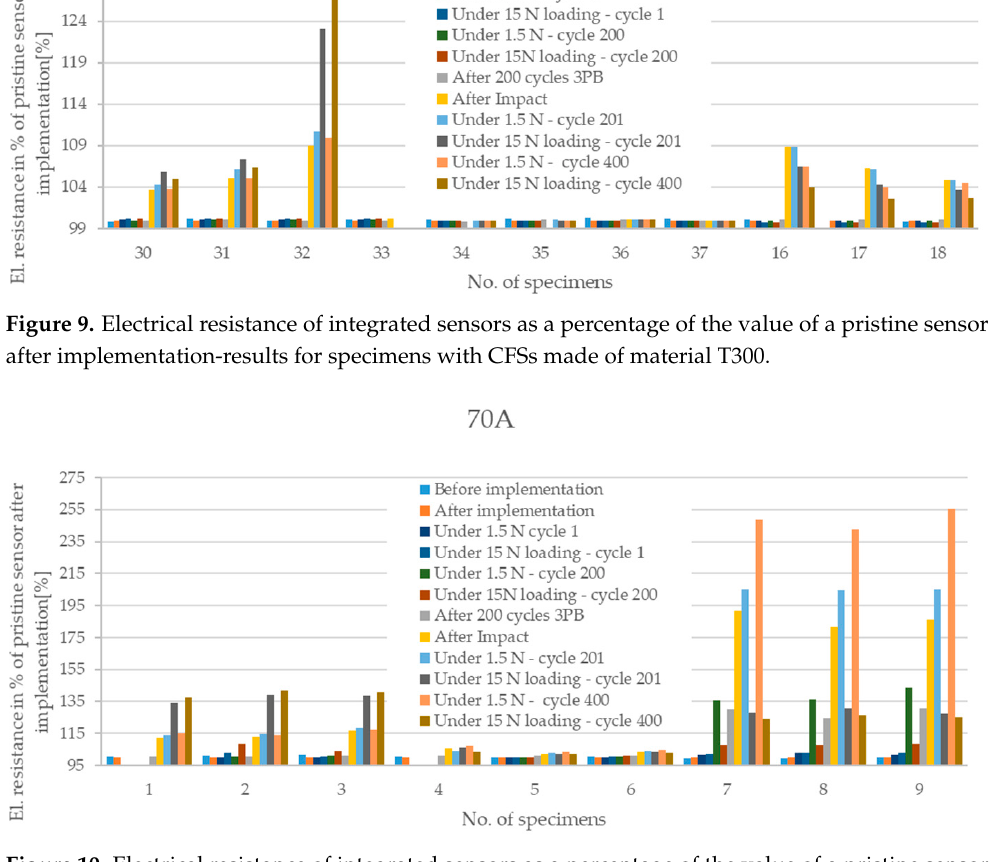
Figure 11. Electrical resistance of integrated sensors as a percentage of the value of a pristine sensor after implementation-results for specimens with CFSs made of material 95 A . Peak-to-peak values after impact for sensors made of the most brittle material 95 A are not given, because the specimens with sensors of this type were not subjected to the second campaign of cyclic loading. 3.3. Active Thermographic Inspection and Computer Tomography An active thermographic inspection of the specimens before loading revealed damage to the electrical contacts of the sensors made of pitch carbon fiber tow 95 A. The temperature profile along the sensor with the damaged contact area is shown in Figure 12. In Figure 13. The temperature profile of a sensor without any pre-damage is depicted. Six out of 9 specimens with implemented sensors made of material 95 A were definitely damaged during manufacturing or during implementation. Two specimens were indeterminate regarding damage to the sensor, and no data were provided for one specimen. This demonstrates the sensitivity for the structural integration of carbon fiber sensors made of brittle ex-pitch filaments.